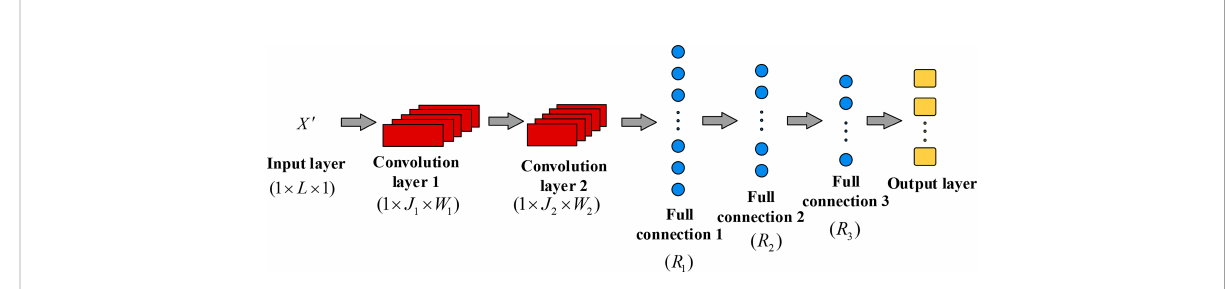
FIGURE 4 The proposed adaptive source sparsity model based on a causal